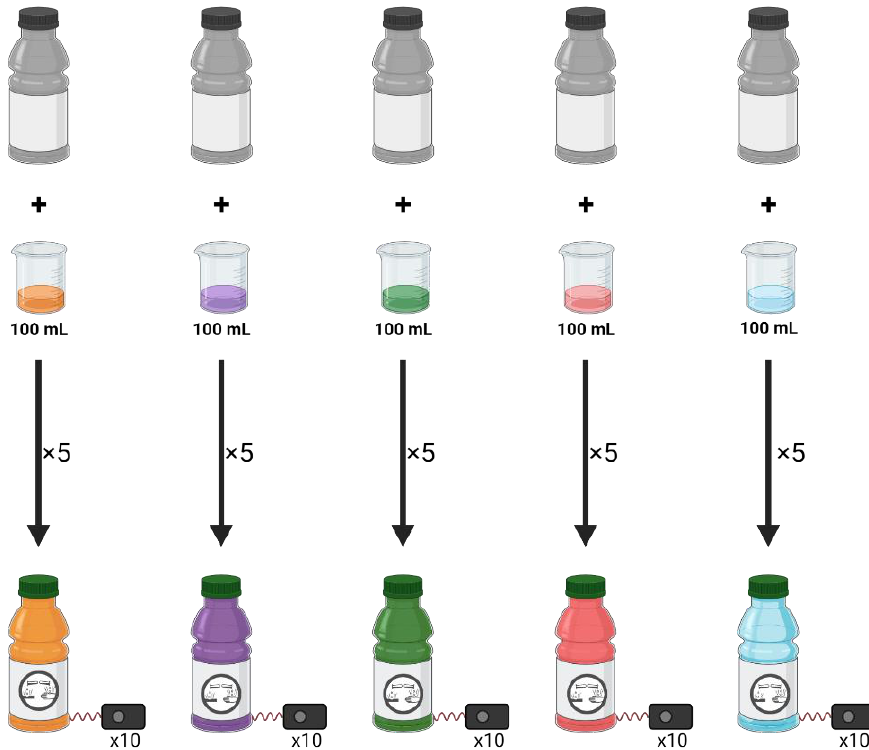
Figure 2. Graphical summary of the sample preparation and analysis during the data collection stage. Aliquots of 100 mL of each corrosive substance were poured into plastic bottles of PET and HDPE. Five aliquots of each combination of corrosive substance and plastic material were prepared and scanned 10 times each using NIR spectroscopy. Created with BioRender.com .